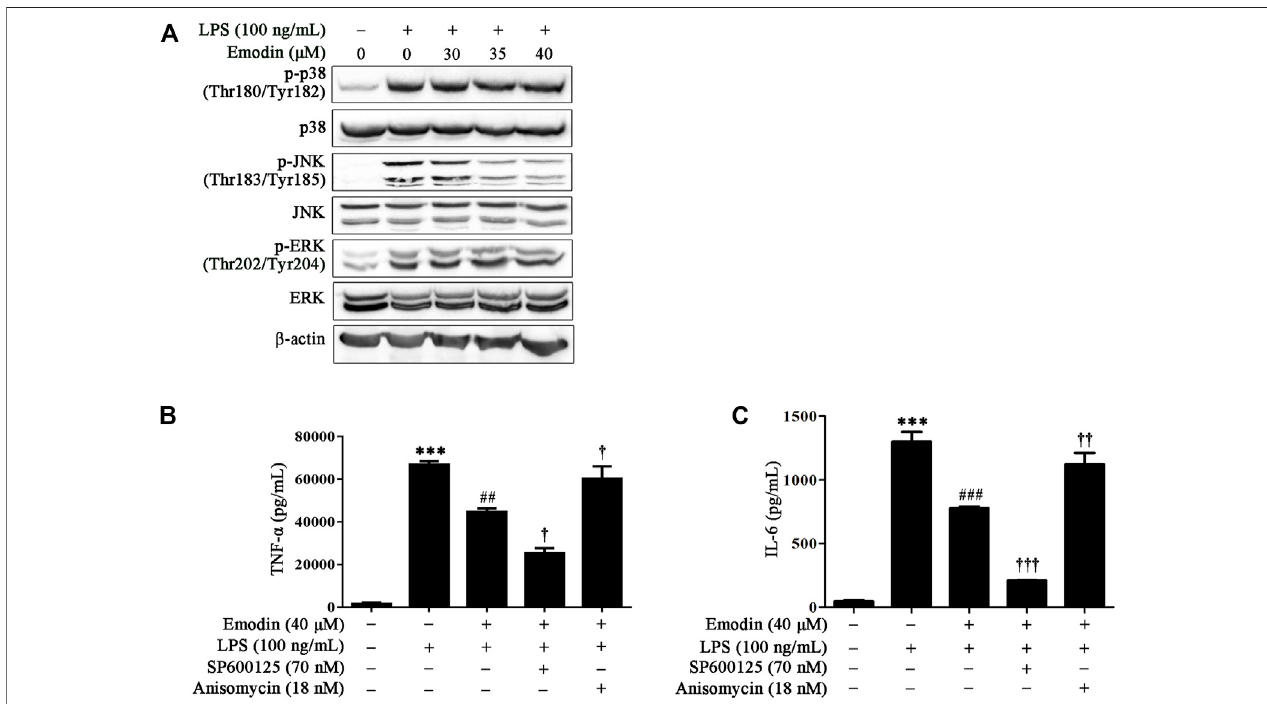
FIGURE 2 | Emodin inhibits LPS-induced in fl ammation via the JNK pathway in RAW264.7 cells. (A) Emodin suppresses activation of the JNK pathway in LPS- stimulatedRAW264.7cells.RAW264.7cellswerepretreatedwithemodin(40 μ M)for2 hfollowedbyexposuretoLPS(100 ng/ml)for18 h.Thentheexpressionlevelsof p-p38(Thr180/Tyr182),p38,p-JNK(Thr183/Tyr185), JNK,p-ERK(Thr202/Tyr204), andERKwereassessed usingWestern blotting. (B,C) Anisomycin counteracts the inhibitory effects of emodin on the secretion of in fl ammatory cytokines. RAW264.7 cells were pretreated with SP600125 (8 μ M) for 2 h or anisomycin (18 nM) for 4 h, and then treated with emodin (40 μ M) for 2 h followed by exposure to LPS (100 ng/ml) for another 18 h. The levels of TNF- α (B) and IL-6 (C) in supernatant were measured by ELISA. Data are presented as mean ± SEM, n = 3. *** p < 0.001 compared with the control group; ## p < 0.01, ### p < 0.001 compared with the emodin group; † p < 0.05, †† p < 0.01, ††† p < 0.001 compared with the emodin